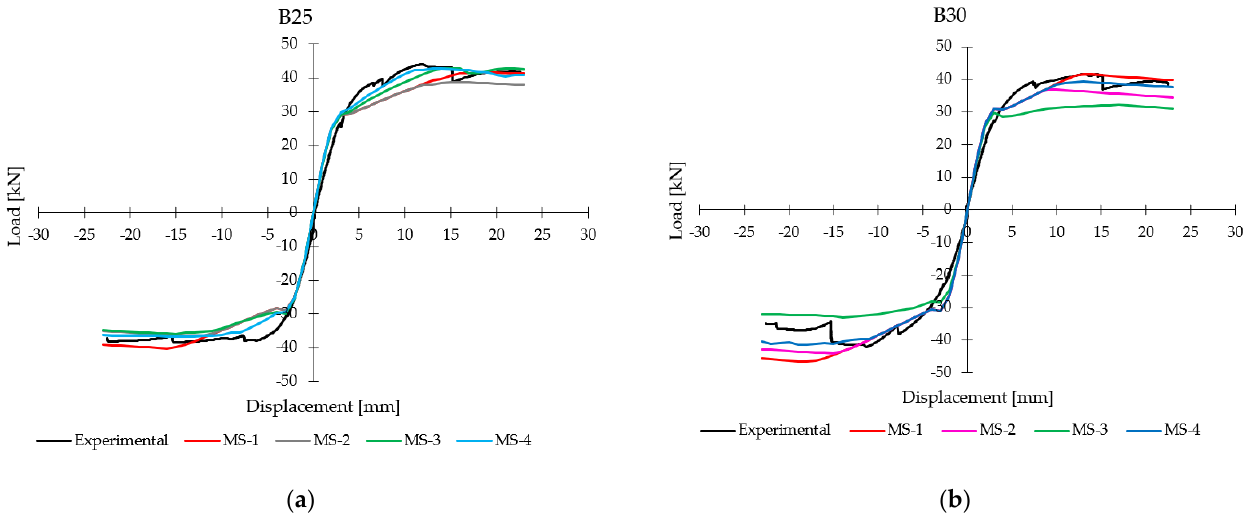
Figure 18. Comparison between experimental and numerical response, monotonic curves. ( a ) Column B25; ( b ) column B30.